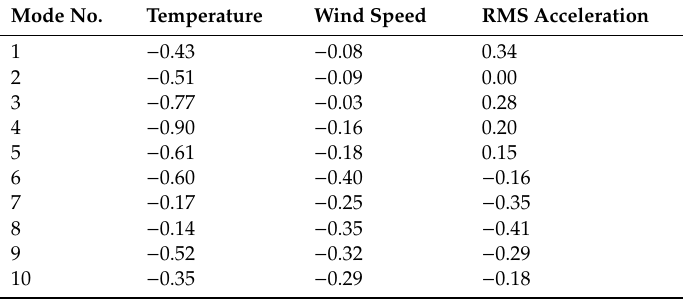
Figure 14. Comparison of identified modal frequencies while considering three different environmental factors on July 29th and 30th. The middle section with a yellow background represents the period with wind speed exceeding 17.2 m/s. Table 2. Pearson correlation coe ffi cients for the three environmental factors and the target modal frequencies during the first